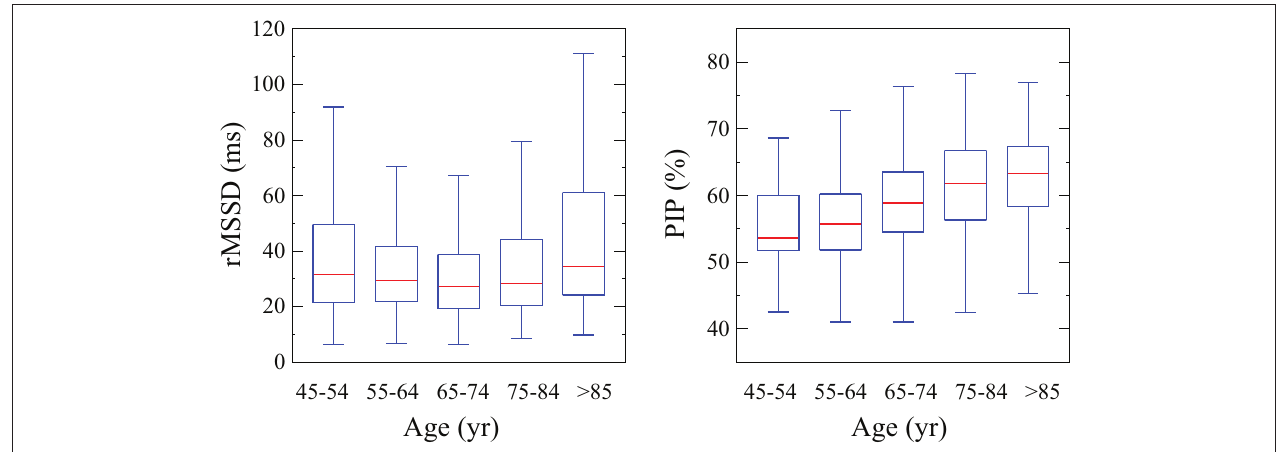
FIGURE 2 | Tukey boxplots of ln(rMSSD) and PIP for participants in successive age groups. PIP, percentage of inflection points; rMSSD, root mean square of the successive differences.